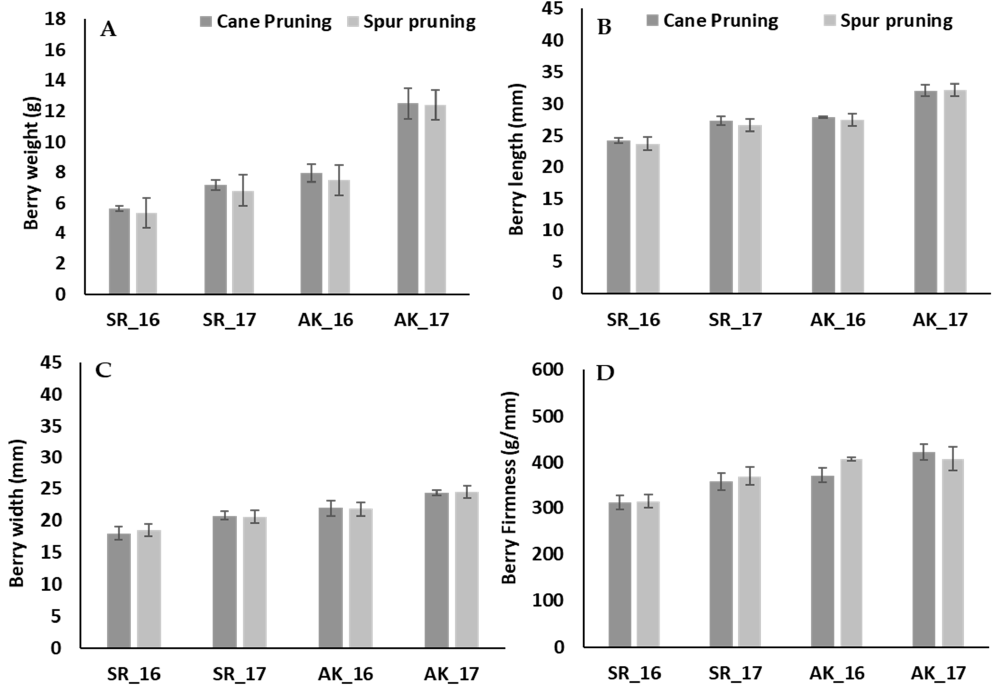
Figure 3. Effect of Head training, cane pruning and Quadrilateral cordon training, spur-pruning systems on berry weight ( A ), length ( B ), width ( C ), and firmness ( D ) of Scarlet Royal (SR) and Autumn king (AK) table grapes during 2016 and 2017 seasons. ANOVA statistical analysis was used to measure the differences among treatments at a 0.05 significance level. Error bars represent the standard deviation.